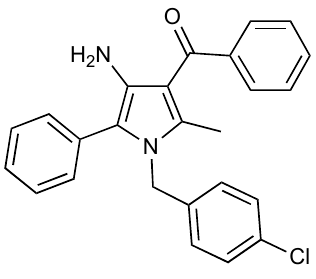
Figure 1. Chemical structure of the synthetic cannabinoid URB447.